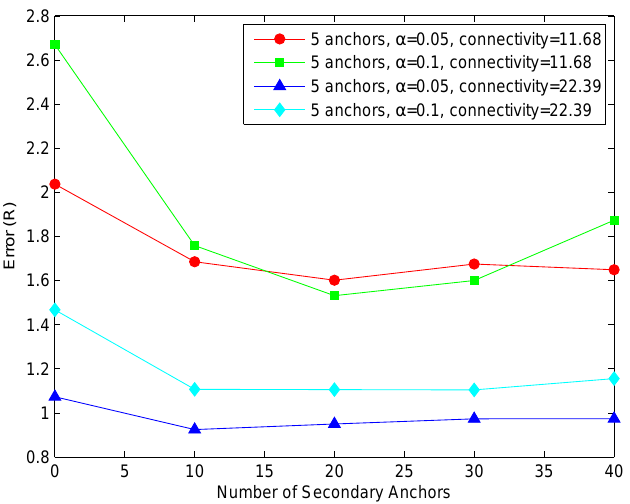
Figure 17 . 5 Anchors, C-shaped